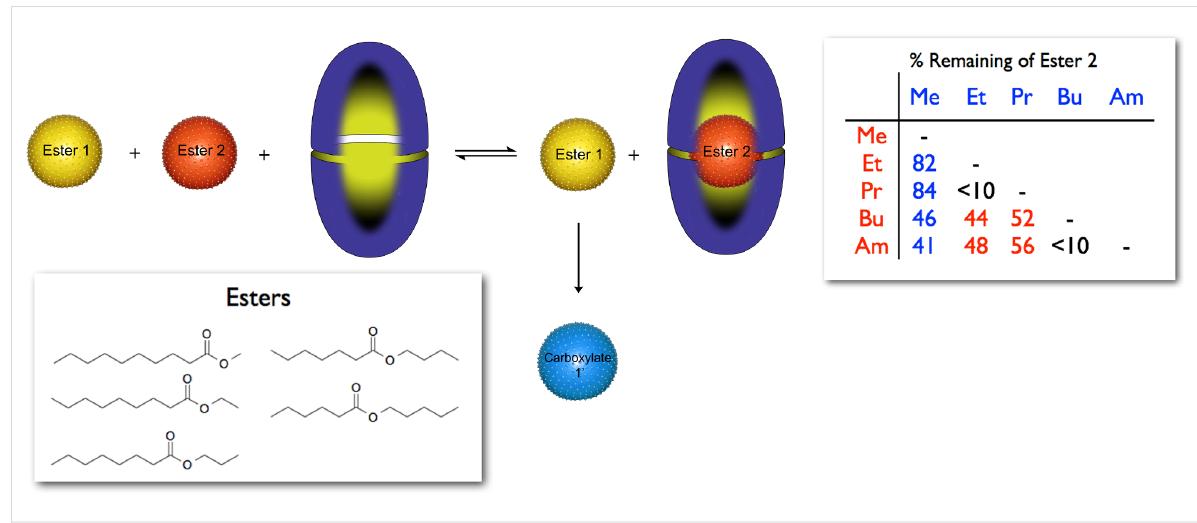
Figure 11: Schematic of the competition of two esters for the capsule formed by octa-acid. The ester that binds weakest to the host (arbitrarily Ester 1) remains in solution and is hydrolyzed to the corresponding carboxylate. The table shows the percentage of Ester 2 remaining after all of Ester 1 has been hydrolyzed. The color of the font of listed values indicates which ester of the pair predominated (red listed vertically, blue horizontally).